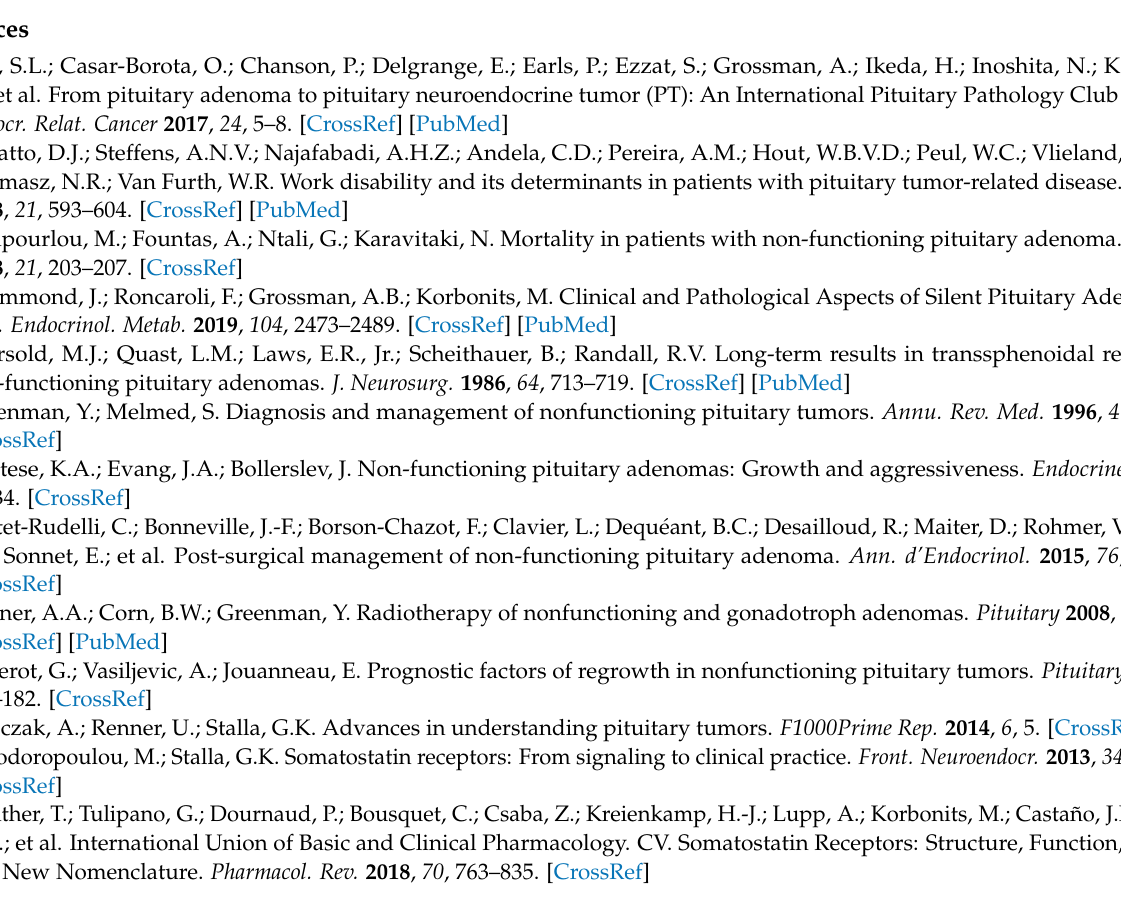
Table S4. Longitudinal data of rats treated with pasireotide